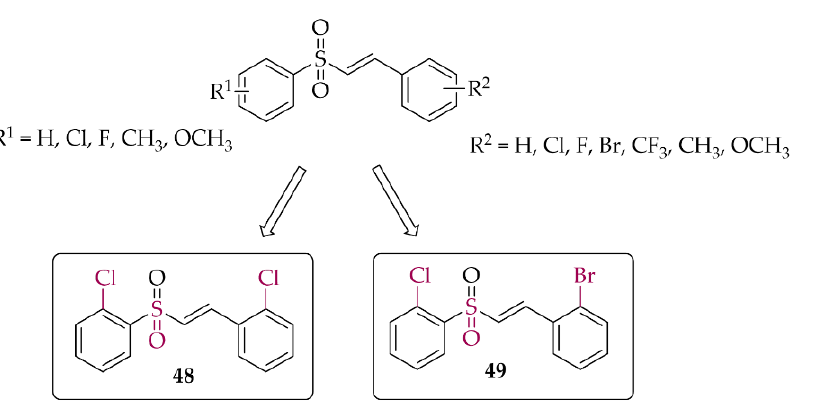
Figure 36. Structures of the most potent vinylsufonyl Nrf2 activators synthesised by Song et al. [84].